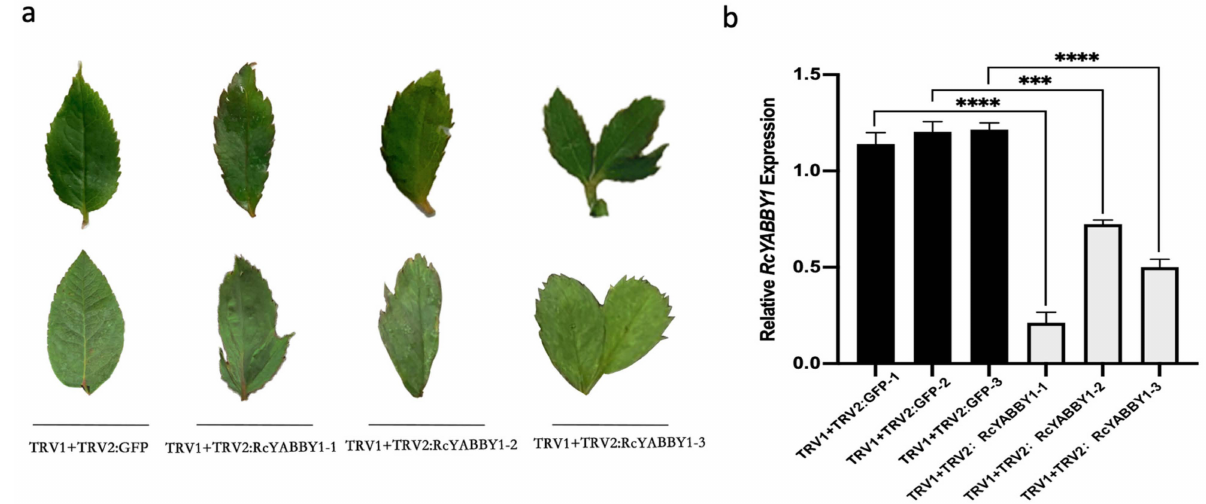
Figure 7. Silencing of RcYABBY in Rosa multiflora ‘Libellula’: ( a ) leaf phenotypes of R. multiflora ‘Libellula’ TRV1 + TRV2:GFP (control) and TRV1 + TRV2:RcYABBY1 (RcYABBY1 silenced); ( b ) qPCR analysis to determine gene silencing efficiency. Asterisks indicate significant differences among treatments (*** p < 0.001; **** p < 0.0001). The vertical bars indicate the standard deviations of the means of three